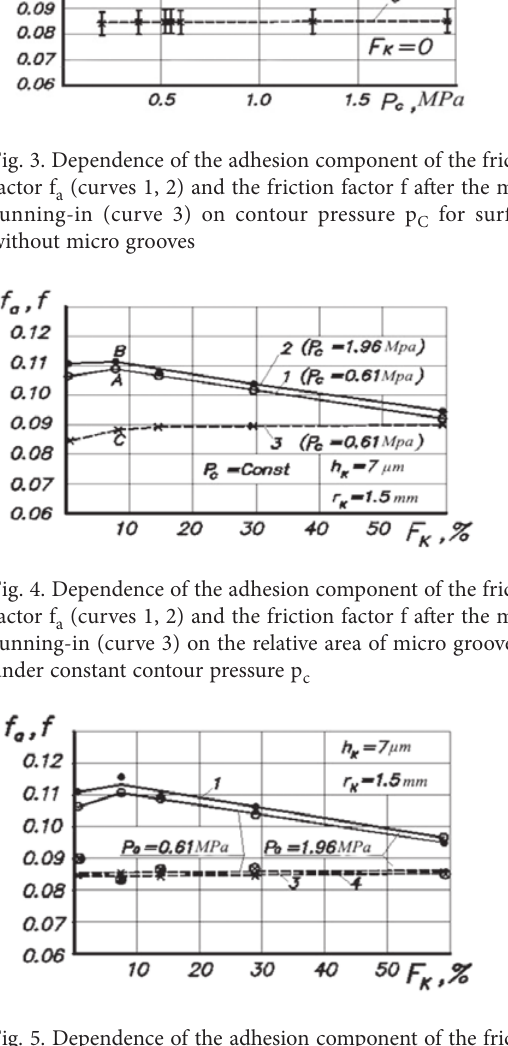
Fig. 5. Dependence of the adhesion component of the friction factor f а (curves 1, 2) and the friction factor f after the micro running-in (curves 3, 4) on the relative area of micro grooves F